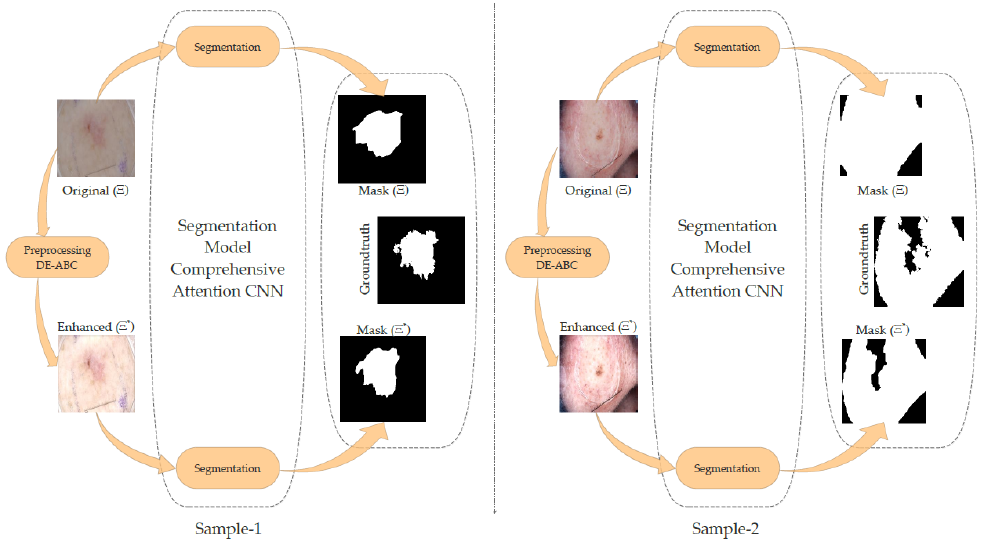
Figure 7. DE-ABC preprocessing effects on comprehensive attention CNN